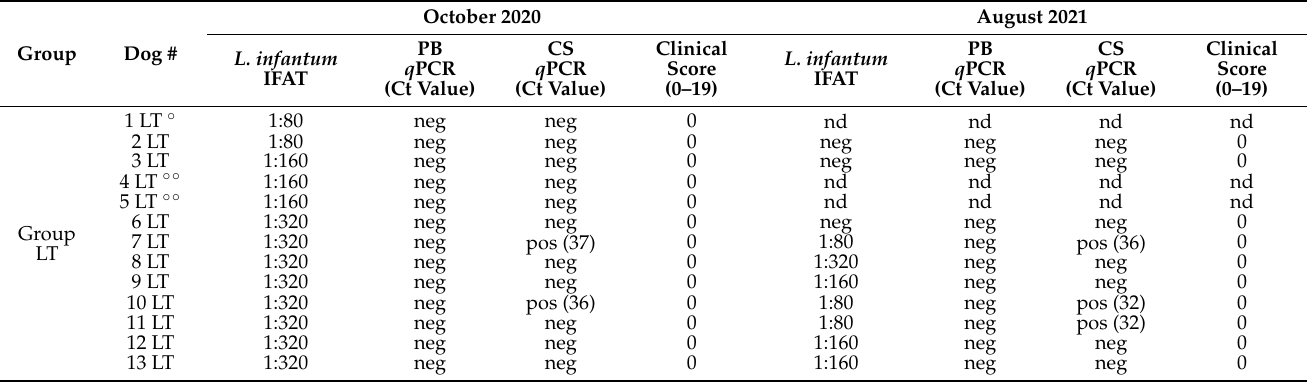
Table 2. Enrolled dogs divided in two groups according to the anti- L. infantum antibody titres (i.e., ≤ 1:320 (group low titre, LT) and >1:320 (group high titre, HT)) and followed-up in August